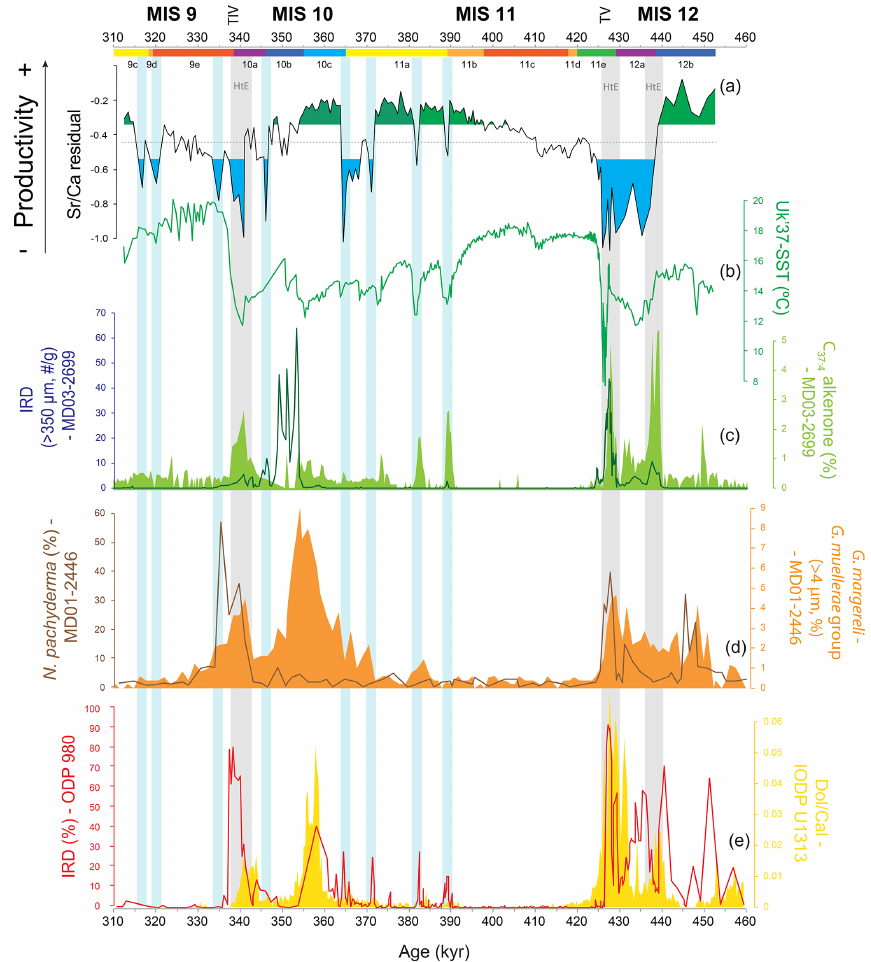
Figure 4. Coccolithophore paleoproductivity reconstruction with “high” and “low” coccolithophore productivity levels highlighted in green (cid:48) and blue shading, respectively (a) , compared to (b) U k -based reconstruction of sea surface temperature from core MD03-2699 (Rodrigues et 37 al., 2011); (c) ice-rafted debris (IRD) abundance (Voelker et al., 2010) and heptatriatetraenone (C 37 : 4 alkenone) abundance (Rodrigues et al., 2011), both from core MD03-2699; (d) Neogloboquadrina pachyderma relative abundance and Gephyrocapsa margereli and G. muellerae group relative abundance, both from core MD01-2446 (Marino et al., 2014); (e) percentage IRD from ODP Site 980 (McManus et al., 1999) and dolomite / calcite ratio from IODP Site U1313 (Stein et al., 2009). Note that the MD03-2699 lithic fragments were counted in a coarser size fraction ( > 315µm) than the standard size fraction ( > 150µm; Hemming, 2004) and thus most likely only record major ice-rafting events at the IbM, as suggested by Marino et al. (2014). Chronology as in Fig. 3. Vertical bars: grey bars correspond to Heinrich-type events (HtEs) and blue bars to short-lived events of decreased coccolithophore